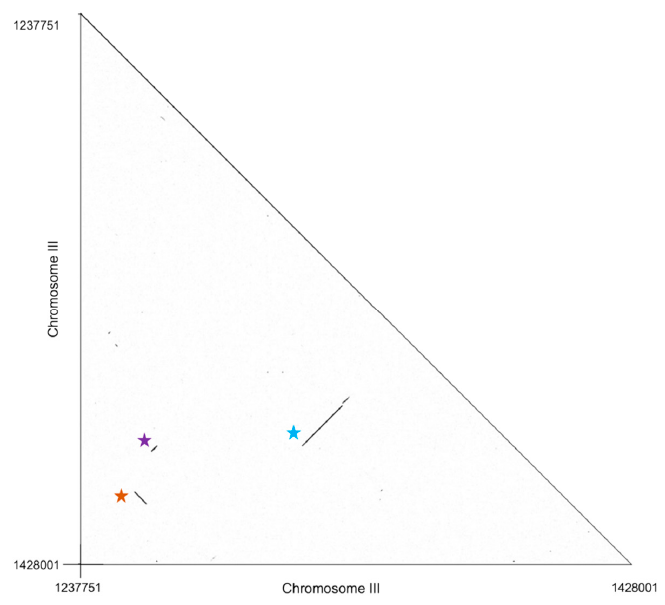
Figure 5. Paralogy in the copy number-variable chromosome III region. Axes report position in the C. posadasii Silveira reference genome in the chromosome III locus from Figure 4. Black points report nucleotide identity. Colored stars identify inferred gene duplications discussed in the Supplementary Note.